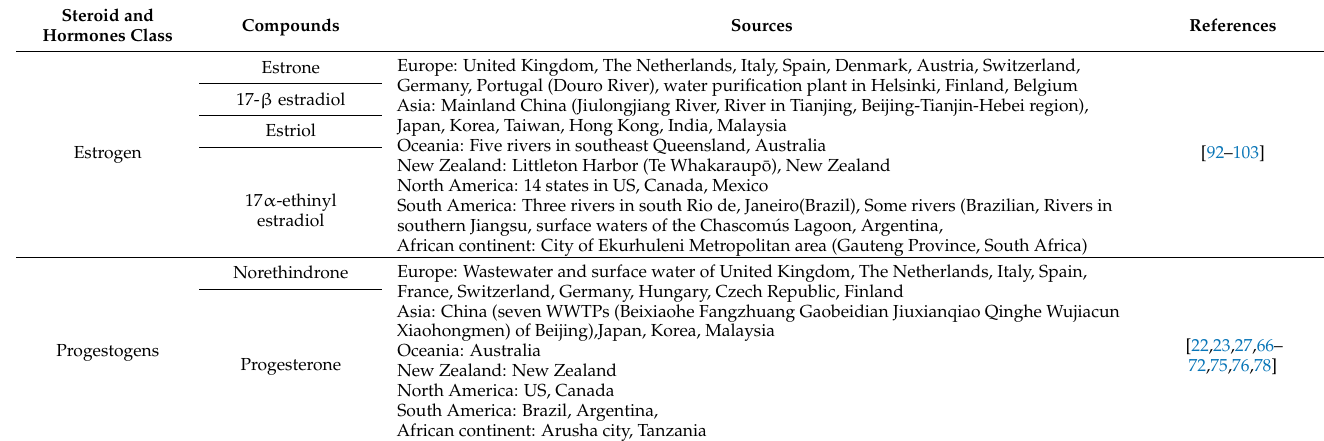
Table 2. Significant incidences of steroid and hormone